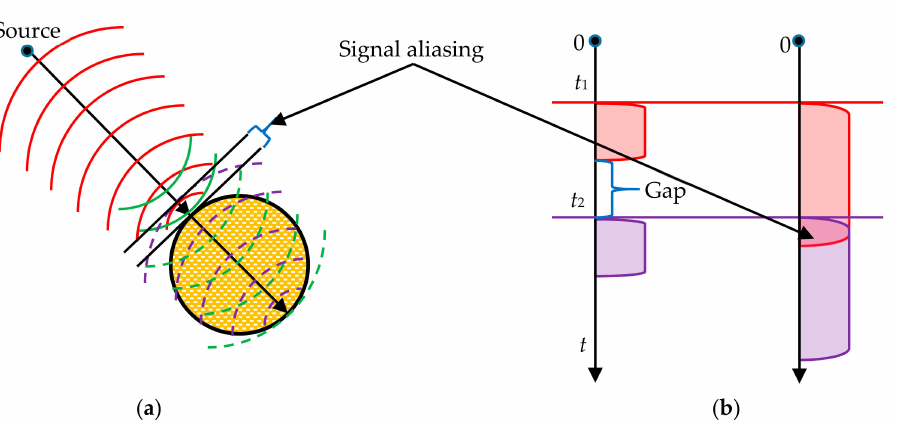
Figure 11. Influence of pulse duration on pipeline echo signal. ( a ) Reflection of acoustic pulses by pipelines; ( b ) variation of echo signal with time at different pulse